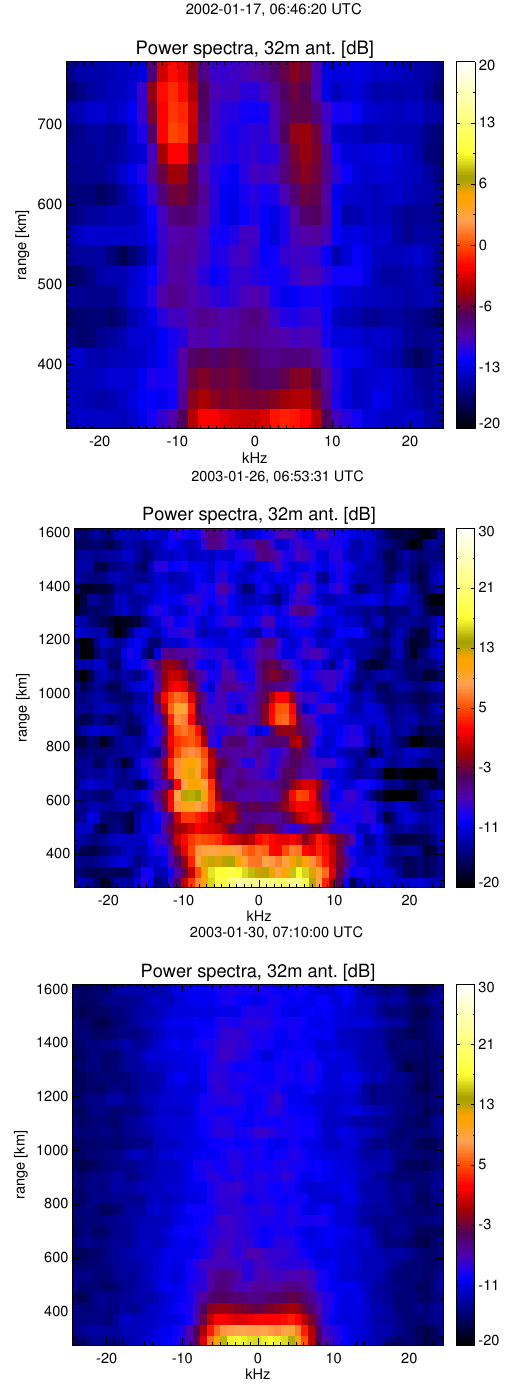
Fig. 4. Three spectra received at the ESR. At the top is an enhanced spectra from event 3, and in the middle is an enhanced spectra from event 4. The third spectra at the bottom is a normal thermal spec- trum from event X , when no enhancements were observed at all. Images from the auroral imagers taken during the same times are shown in Fig. 1. The data has not been background subtracted or corrected for attenuation with range